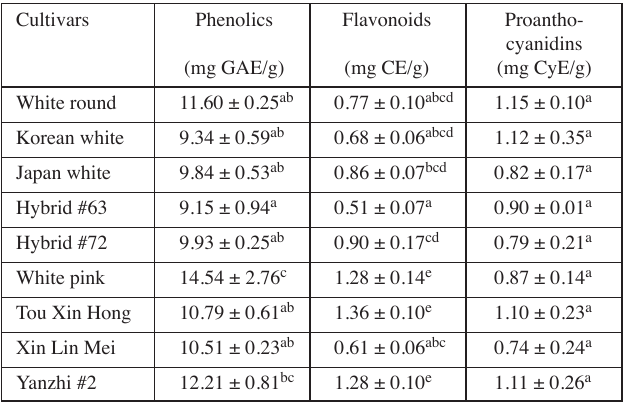
Tab. 1: Total phenolics, flavonoids, and proanthocyanidins in radish seeds